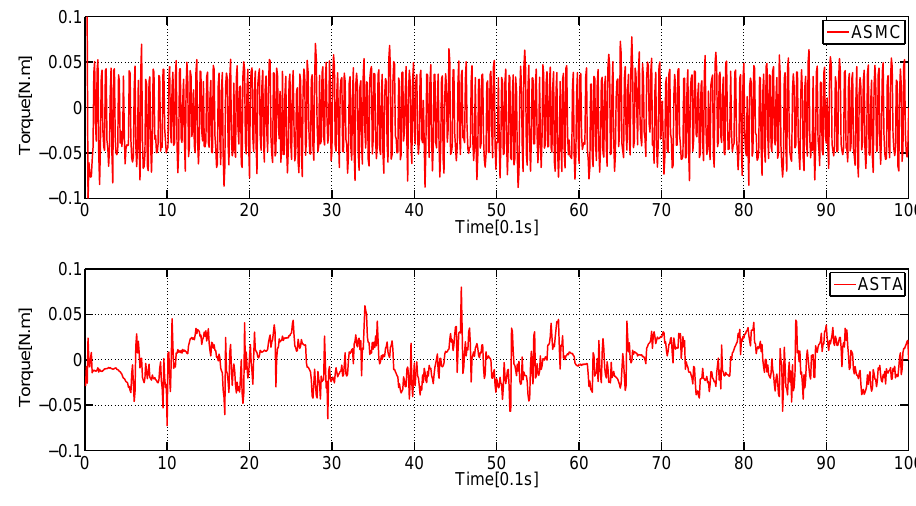
Figure 7. Comparison of the control torque in Case